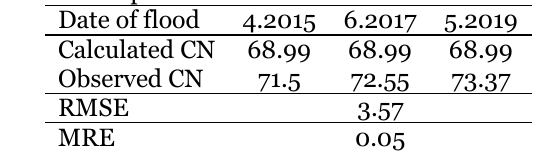
Table 6. Comparison of estimated CN and observed